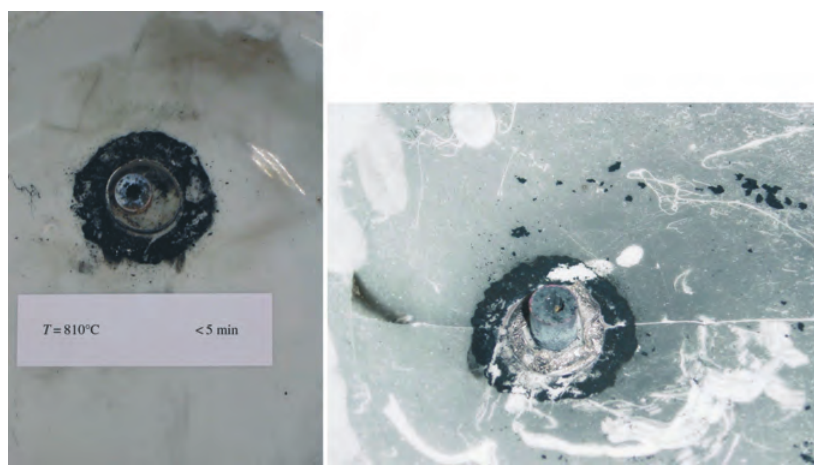
Fig. 4. The results of the oven tests at 810°C with time of 5 min ( left ) and 15 min ( right ).